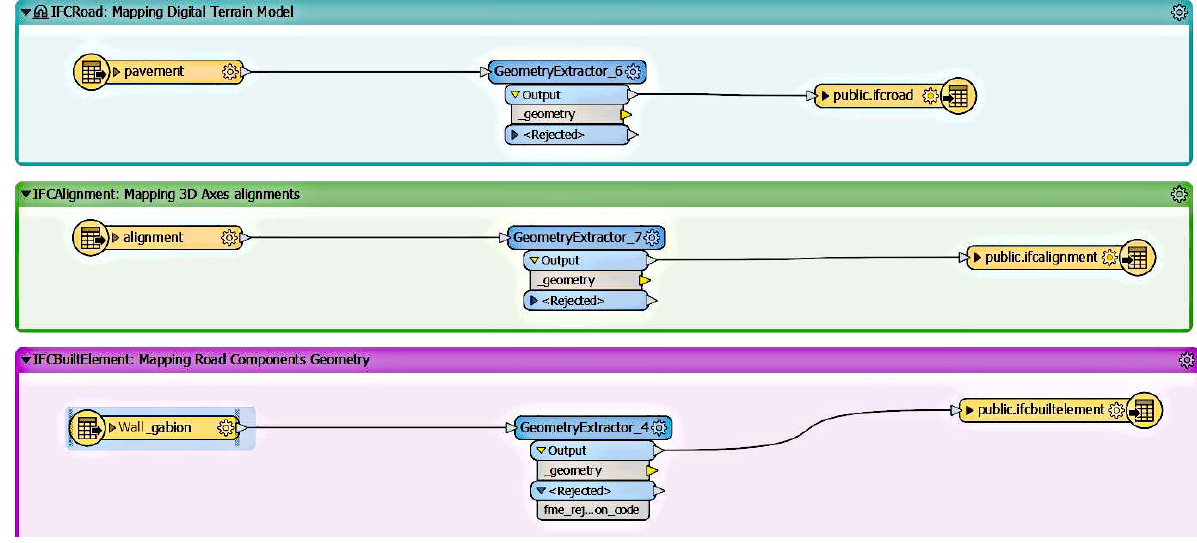
Figure 7. Extract from the ETL mapping procedure.